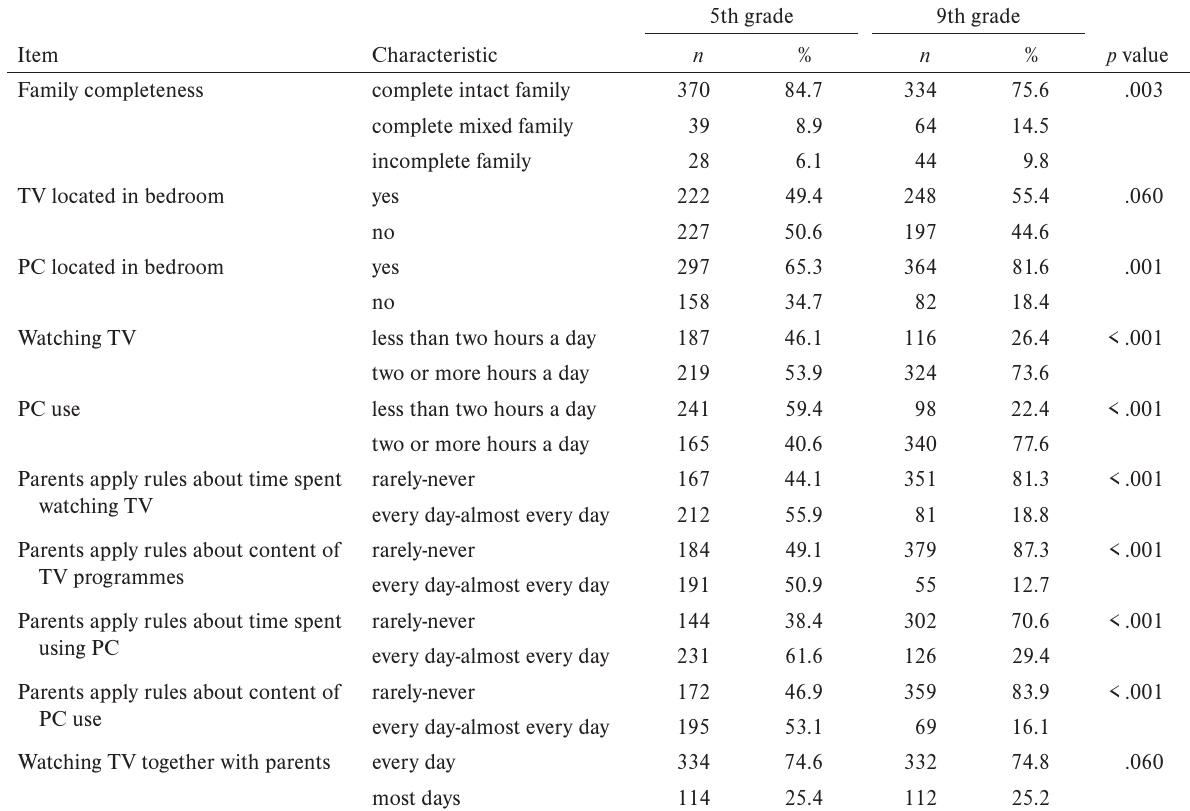
Table 2 Age differences in the prevalence of screen-based behaviour and family-related factors